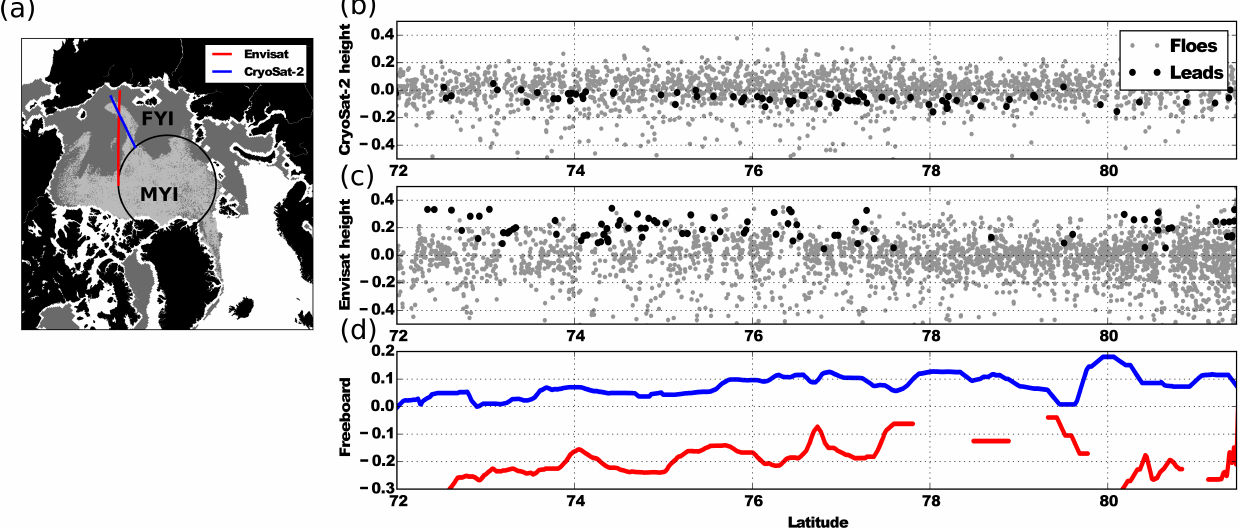
Figure 3. (a) Map of the Envisat (red) and CryoSat-2 (blue) tracks (both monitored on 24 February 2011) selected for the along-track analysis of the radar freeboard. The light shading shows MYI regions (defined as sea ice with a MYI fraction above 0.7) and the dark grey shading shows FYI regions (defined as sea ice with a MYI below 0.7). (b) CryoSat-2 and (c) Envisat leads (grey dots) and ice floes (black dots) surface elevation corresponding to the tracks shown in panel (a) . (d) Envisat (red) and CryoSat-2 (blue) freeboard corresponding to the tracks shown in panel (a)